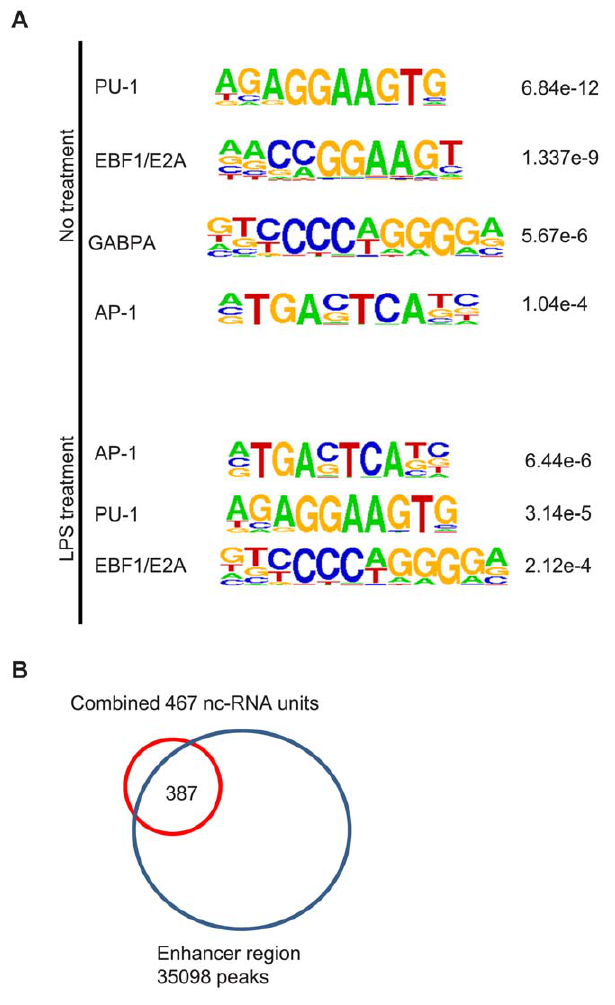
Figure 6. Association of lincRNAs with enhancer markers. A: motifs enriched in the promoter regions of lincRNA that are defined as sequences within the H3K4Me3 clusters of the lincRNAs. B: Venn diagram overlap between lincRNA and enhancer regions that are labeled by CHIP-Seq signatures of PU.1 peaks and H3K4Me1 peaks.